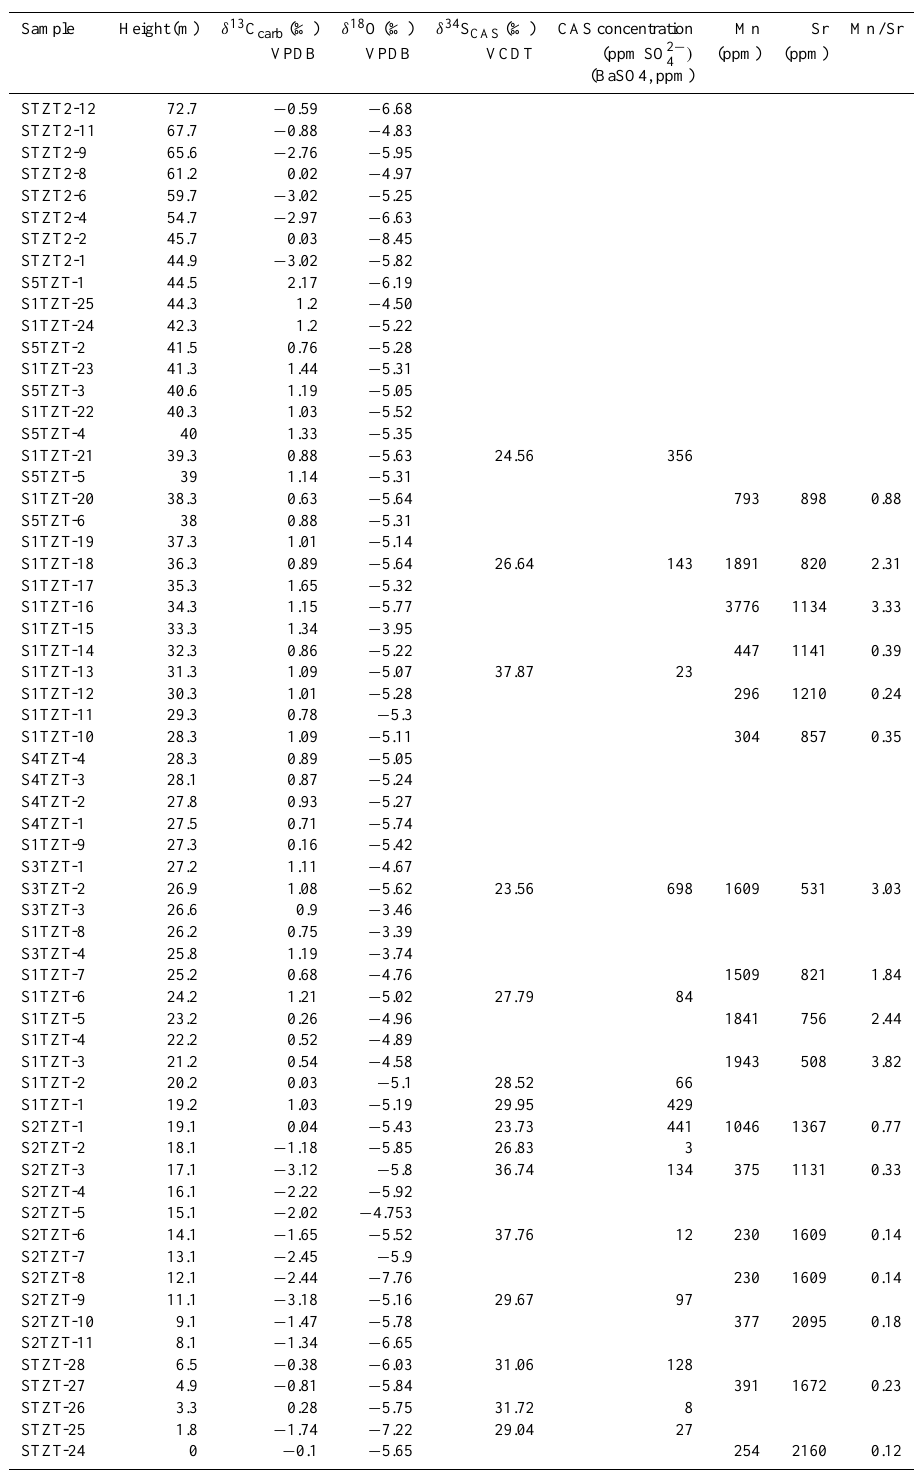
Table C1. Isotopic and trace element data for the Shitouzhai section.